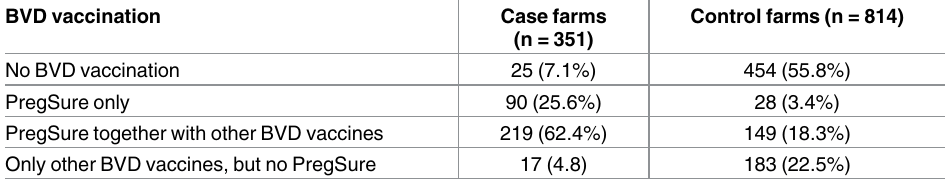
Table 3. Distribution of case and control farms using different BVDV vaccinesin multi-country BNP study (n =